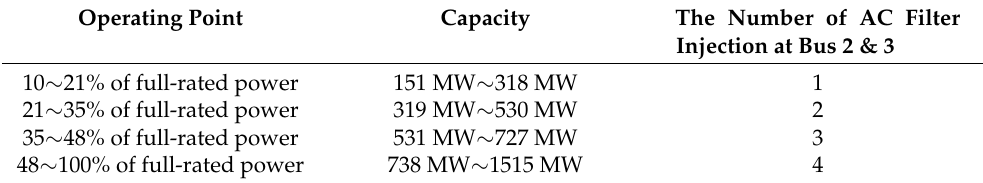
Table 2. Description of AC filter injection corresponding to LCC-HVDC